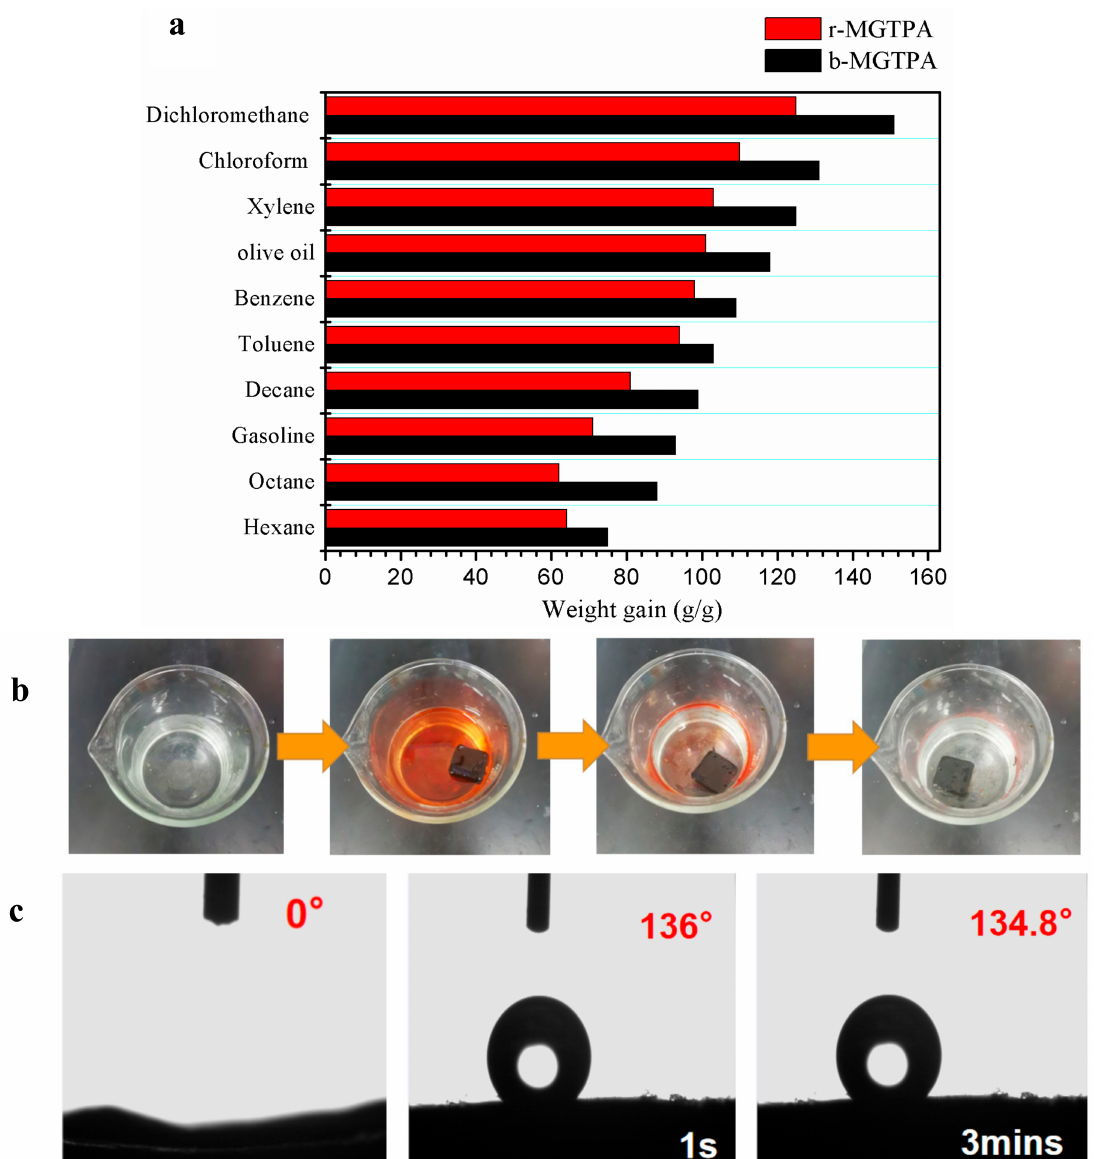
Figure 7. ( a ) Absorption capacity of d-MG 20 TPA and b-MG 20 TPA for various solvents. ( b ) Demon- stration of selective oil (dyed red with Sudan III) absorption atop water using b-MGTPA. ( c ) Water contact angle of the b-GTPA and b-MGTPA taken at 1 s and 3